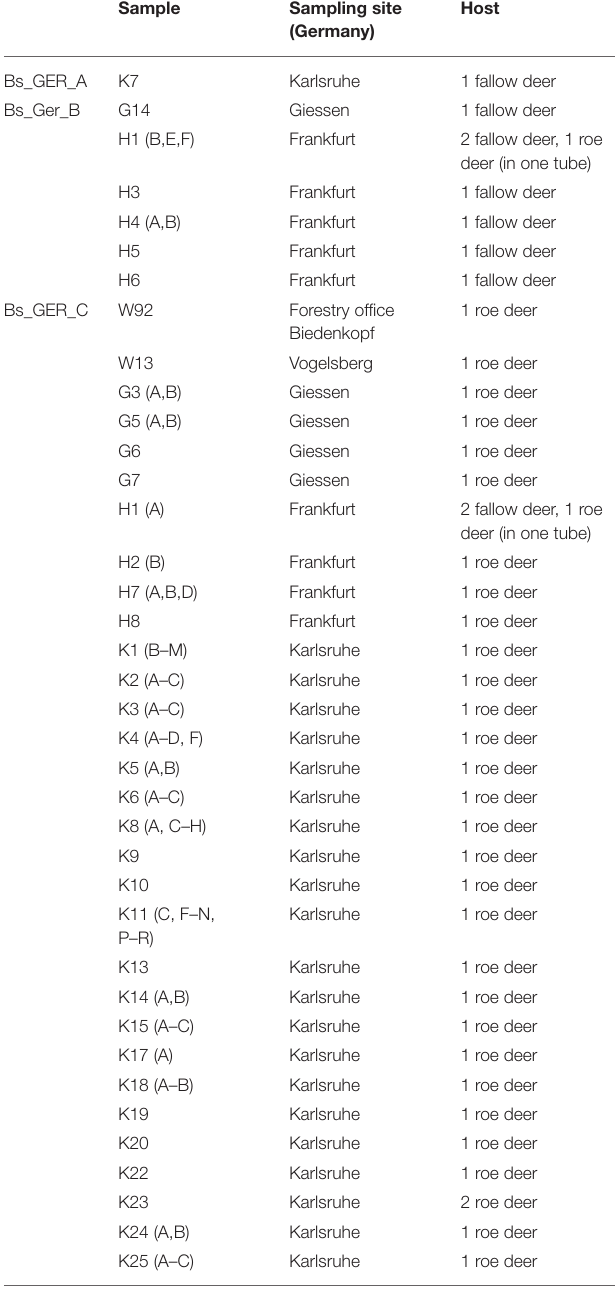
TABLE 2 | Distribution of B. schoenbuchensis rpoB-subtypes and prevalence in fallow deer and roe